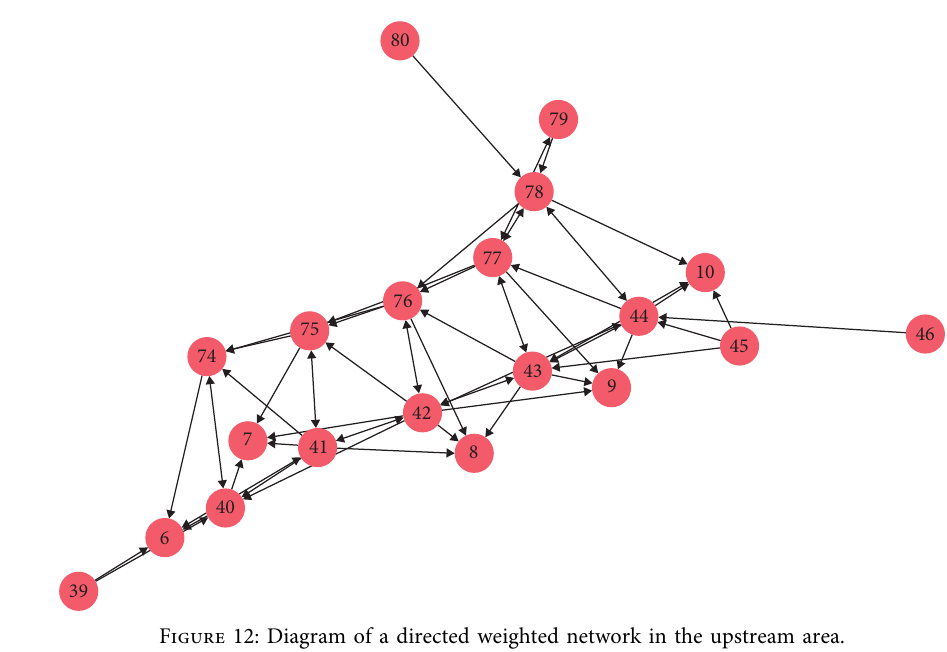
Figure 12: Diagram of a directed weighted network in the upstream area.